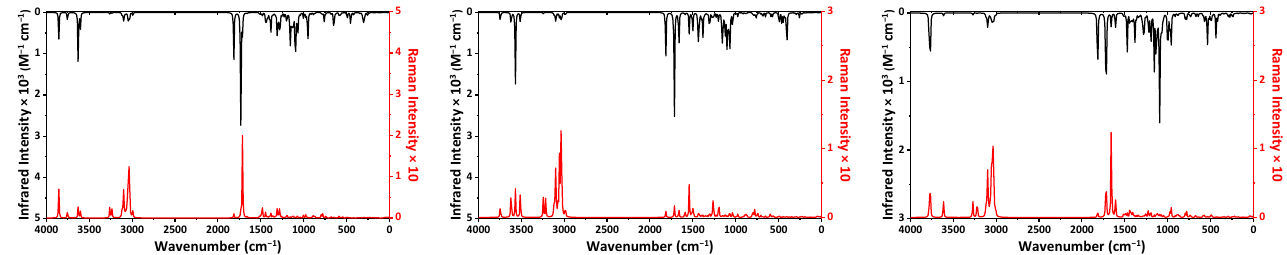
Figure 4. The calculated IR (black) and Raman (red) spectra of the keto-oxime ( left ), keto-hydroxylamine ( middle ), and hydroxyl-oxime ( right ) tautomers of molnupiravir, obtained by using the DFT/B3LYP/6-311++G(d,p) method.